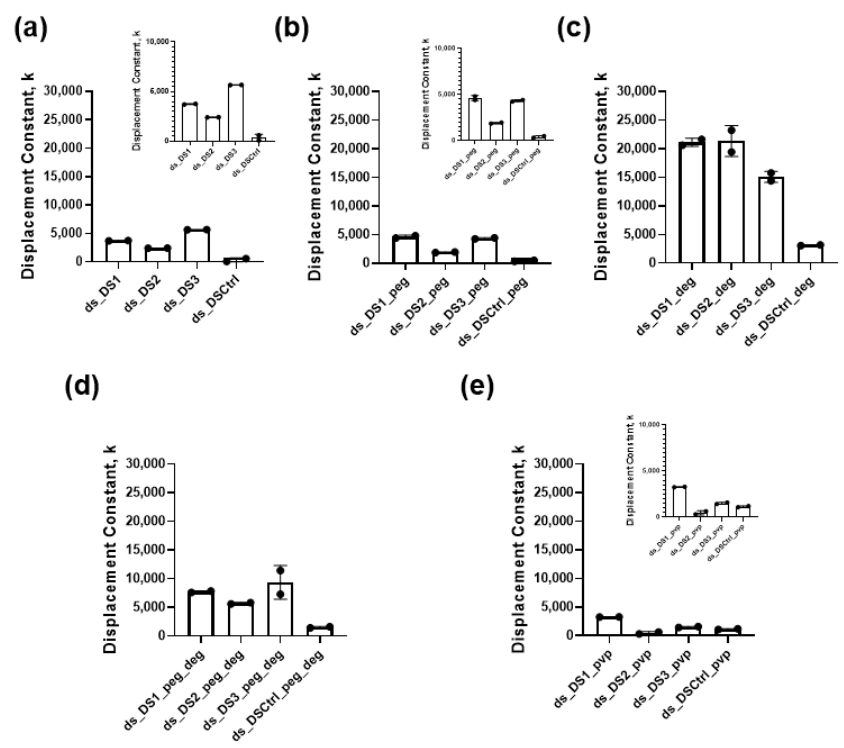
Figure 2. Rate constants of strand displacement k, (L · min − 1 · mol − 1 ) for the duplex (Bmut-CoBmut) displaced with DS1, DS2, DS3, and DSCtrl in ( a ) pure PBS buffer or PBS buffers enriched with ( b ) polyethylene glycol (peg), ( c ) diethylene glycol dimethyl ether (deg), ( d ) mixed peg-deg or ( e ) polyvinylpyrrolidone (pvp) as indicated. The displacement strands (DS1. DS2, DS3, and DSCtrl) are represented in Table 1. Error bars indicate ± SD ( n = 2). For assessment of the data between the different displacement strands in one particular buffer condition, we used one-way ANOVA and calculated p < 0.05. For comparison of the data between the displacement strands in two different buffers, we used two-factor ANOVA with replication and calculated p < 0.05.